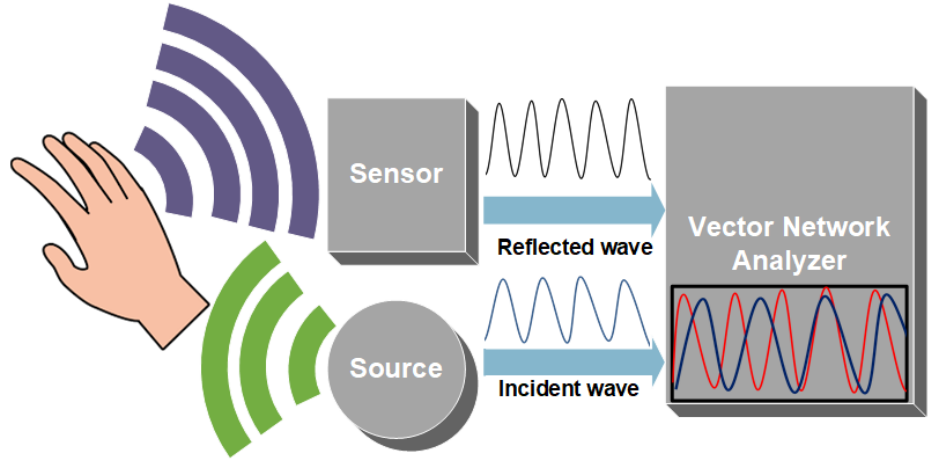
Figure 4. Microwave Spectroscopy working